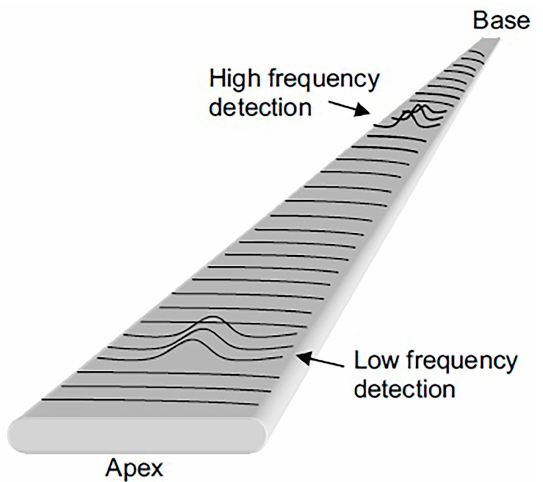
Figure 14. The schematic illustration of an uncoiled basilar membrane demonstrating the tonotopic organisation behaviour along the membrane length [77]. Reprinted by permission from Springer Nature Customer Service Centre GmbH: Springer Nature MICROSYSTEM TECHNOLOGIES MEMS design and modelling based on resonant gate transistor for cochlear biomimetical application, R. Latif et al., COPYRIGHT (2016).